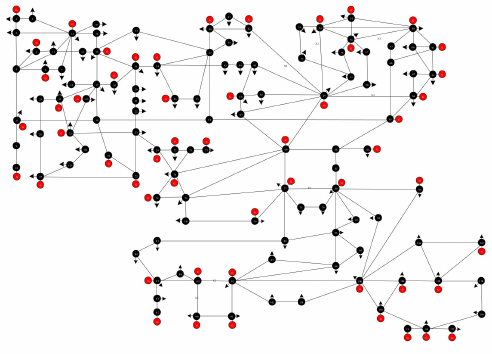
Figure 8. IEEE-118 bus power system.